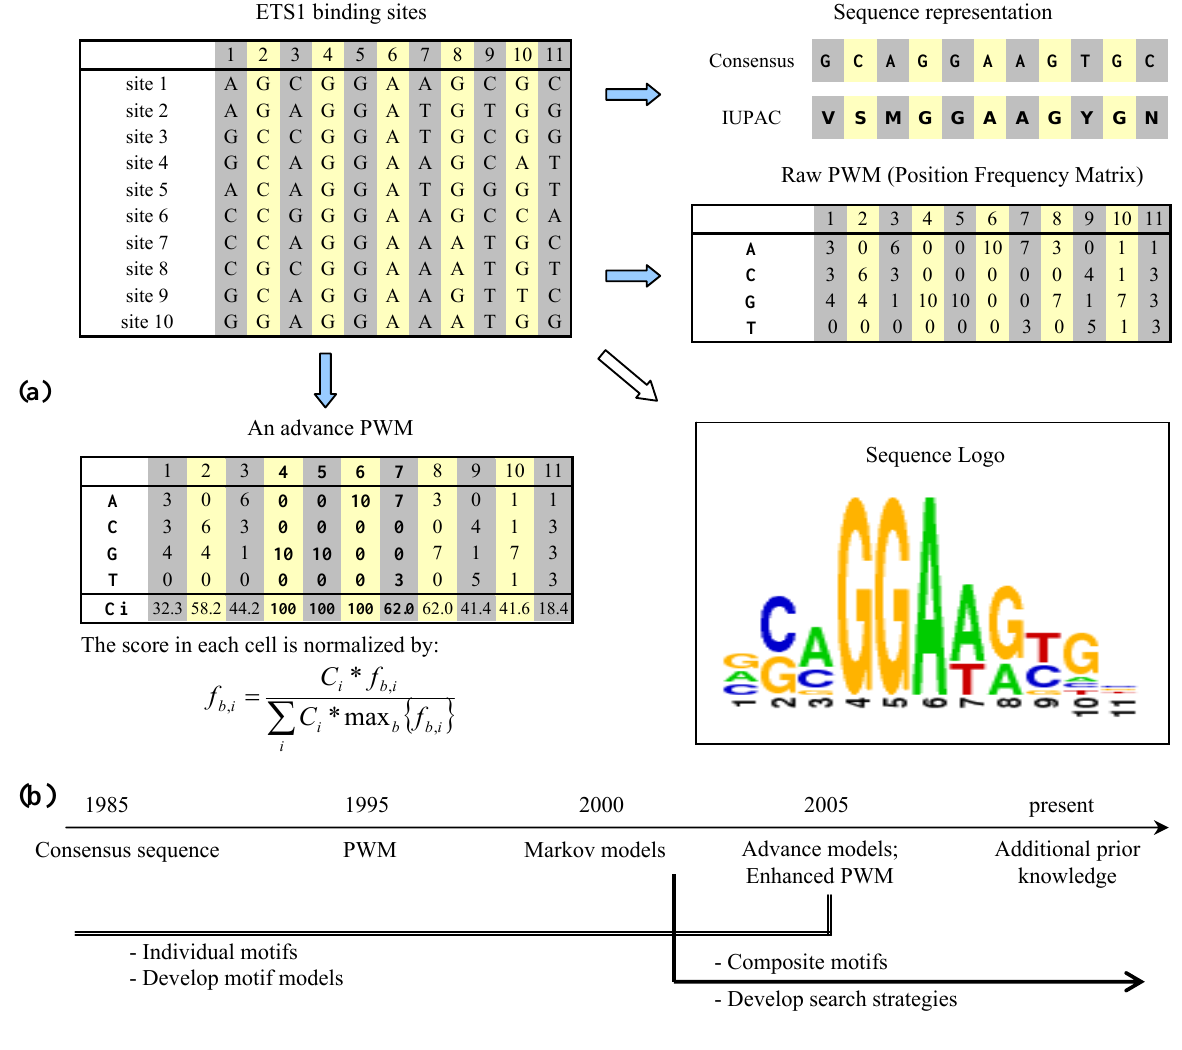
Figure 1 . Binding site representation. (a) Illustration of several motif models for human factor ETS1. Top-left is the collection of binding sites, each of which is called an oligo or conserved sequence; oligos can be aligned with gaps to maximize the motif content but in this case, it is a gap-free alignment. Several models have been displayed and lastly an advance model of PWM is presented [47]; the normalized formula is inferred from the original equation to ensure the rule that the fitness score of a matched oligo can be estimated by taking the sum of the fitness at each position. The ‘bold’ part is the core region of the binding sites i.e. the most conserved region in the binding motif model. Bottom-right is the sequence logo that can quickly visualize the specificity of the conserved information in each column. (b) A brief look on the history of binding motif models. Starting from the first simple representation, consensus sequences, one has developed more advance models to characterize the binding motifs of TFs. However, due to the nature of the binding sites e.g. short, degenerate, etc., the problem has become a challenge and the proposed strategies have been modified when applied to higher eukaryotes e.g. search